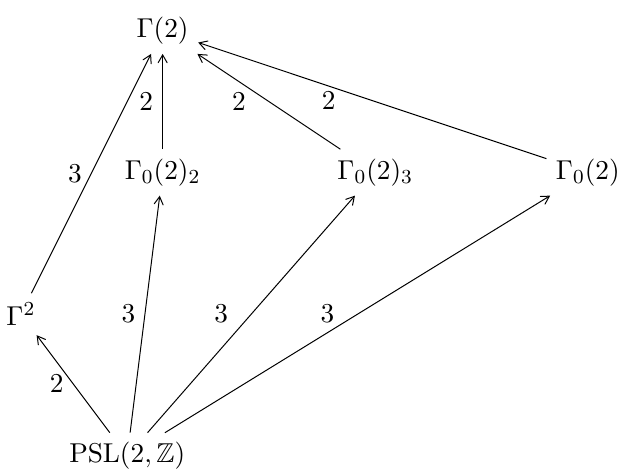
Figure 6 . Congruence subgroups between (cid:0)(1) and (cid:0)(2). The integer on each arrow indicate the degree the group at the end of the arrow inside the group at the